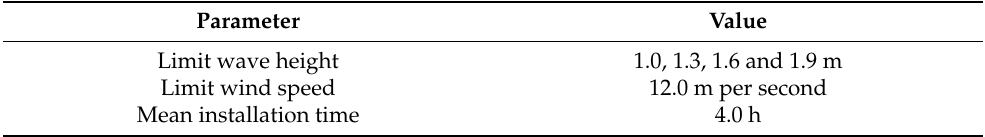
Table 1. Overview of limits used for blade installation in the